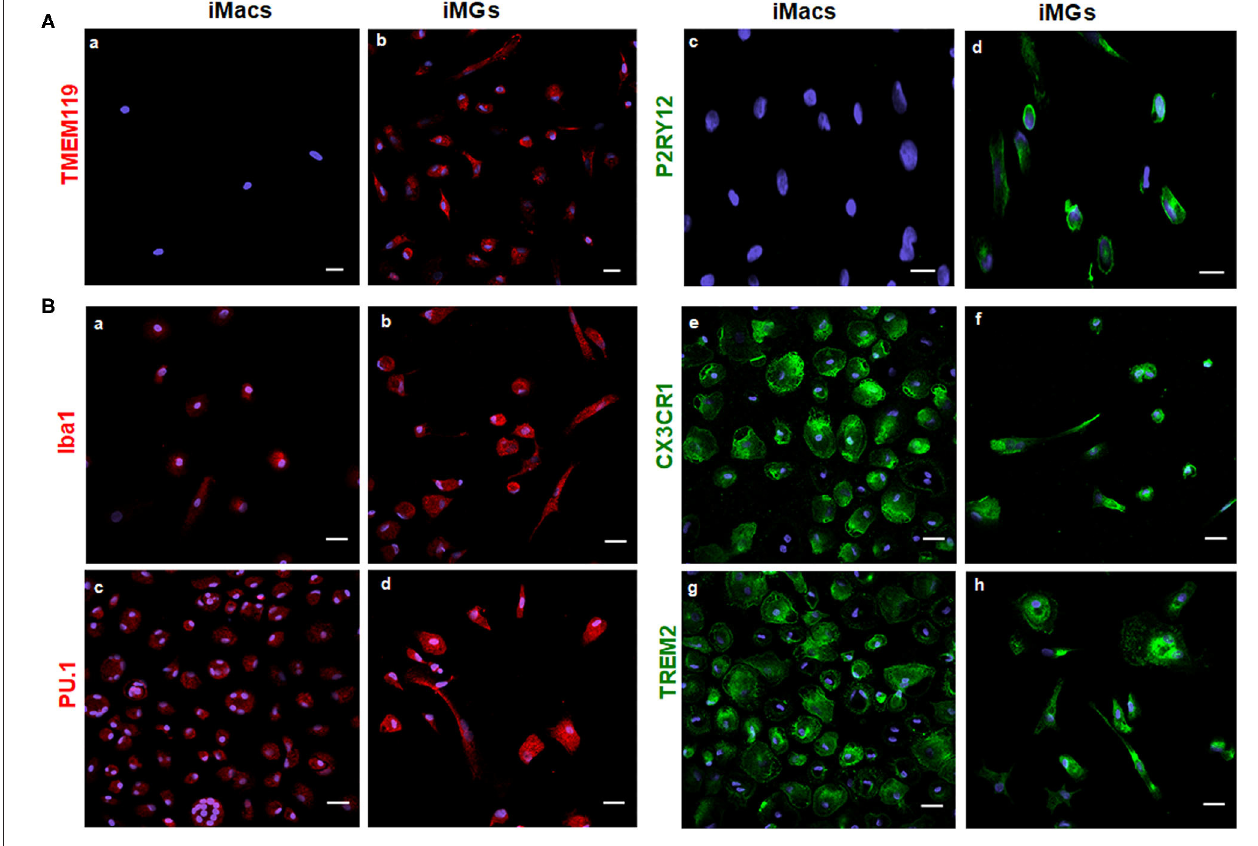
Frontiers in Cellular Neuroscience |